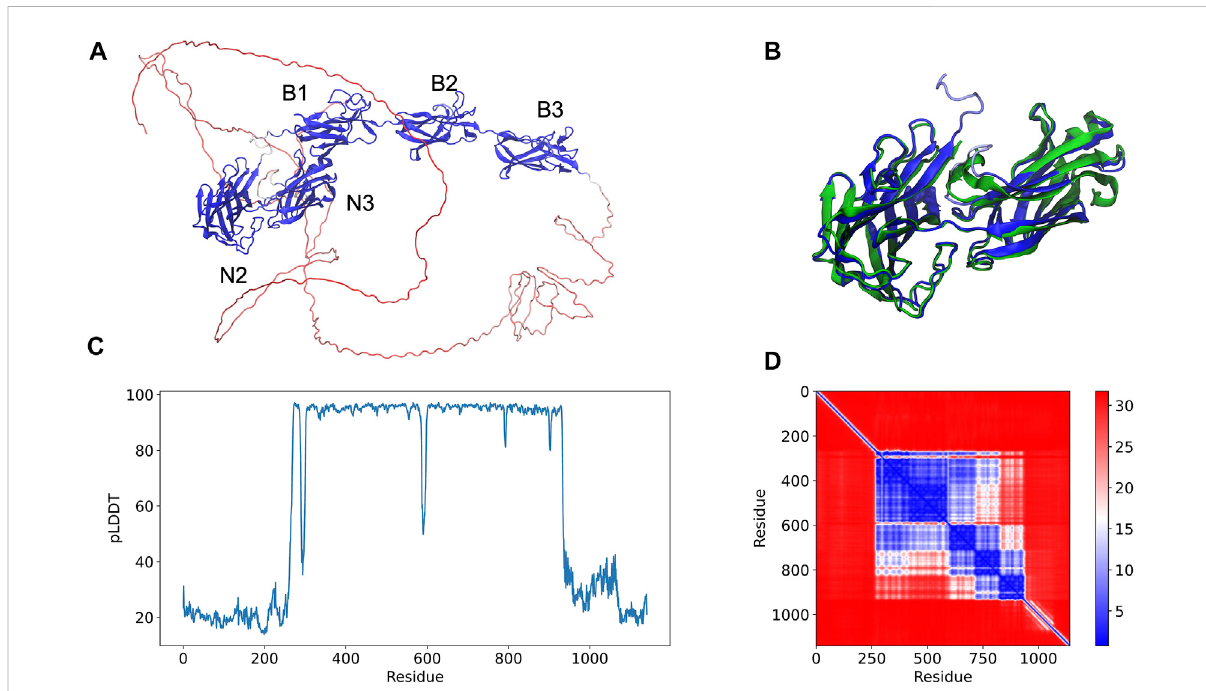
FIGURE 1 Full-length structure prediction of S. aureus serine-aspartate repeat protein (SdrE, Uniprot ID: Q932F7). (A) Top ranked SdrE model is representedincartoonanditsdifferentdomainsareindicated.TheproteiniscoloredbythepLDDTscoresgeneratedbyAlphaFold2wheredarkblue representregionswithveryhighquality(pLDDT > 90)andredrepresentregionswithverylowquality(pLDDT < 50). (B) Structuralalignmentbetween the N2 and N3 regions of the AlphaFold 2 model (dark blue) and SdrE crystallographic structure (cyan, PDB ID: 5WTA). (C) By residue pLDDT scores for thegenerated SdrEmodels. (D) Predicted alignmenterror (PAE) for thebest ranked model. The color at( x, y )correspondsto theexpected distance error in residue x ’ s position, when the prediction and true structure are aligned on residue y